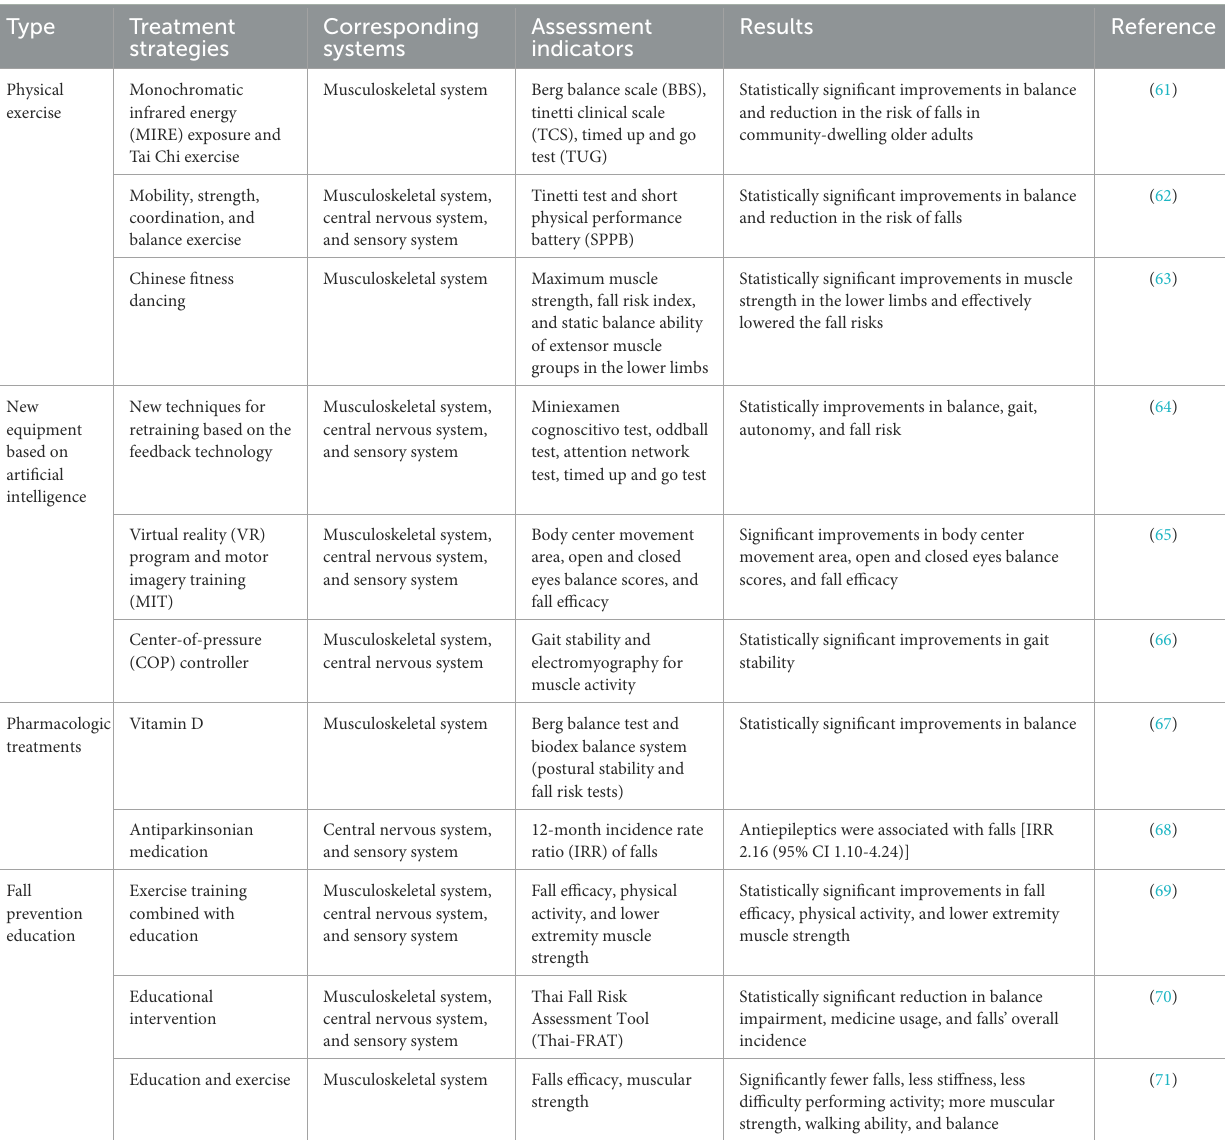
TABLE 1 Summary of studies indicating treatment strategies of balance-disorder-induced falls by regulating different systems in the